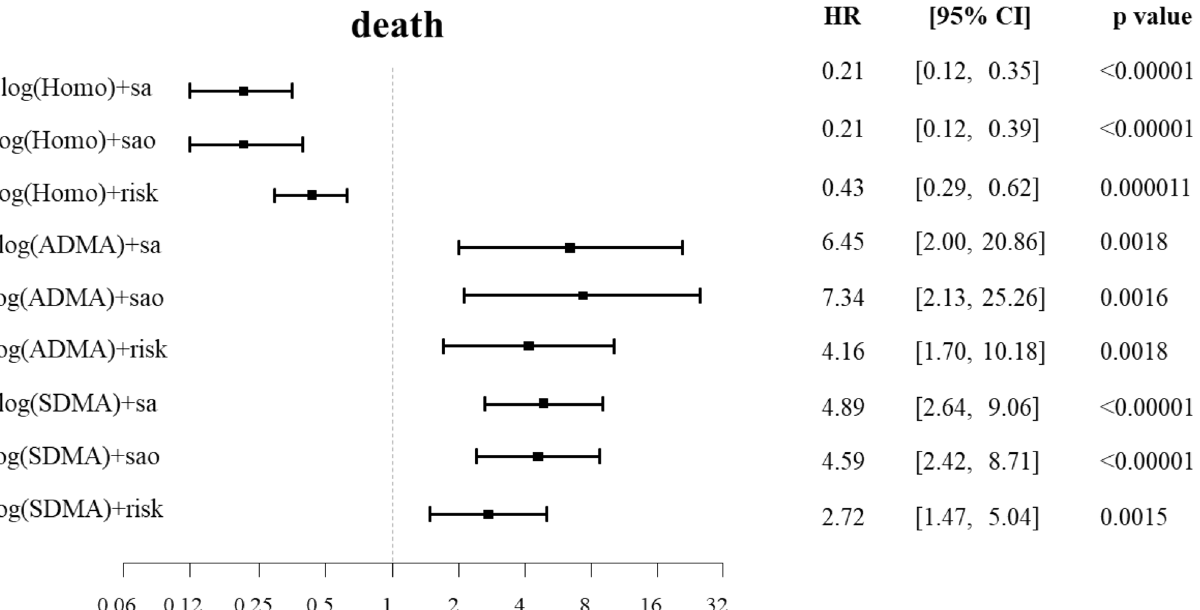
Figure 4. Homoarginine, ADMA, SDMA and the risk of death in the patients with ruled out VTE (controls). Cox regression analysis. Adjustment for sex and age (‘sa’), sex, age and OAC (‘sao’) and for sex, age, OAC, BMI, arterial hypertension, diabetes mellitus, smoking, dyslipidemia, chronic heart failure, history of stroke, creatinine and cancer (‘risk’). Homo, homoarginine; ADMA, asymmetric dimethylarginine; SDMA, symmetric dimethylarginine; BMI, body mass index; HR, hazard ratio; CI, confidence